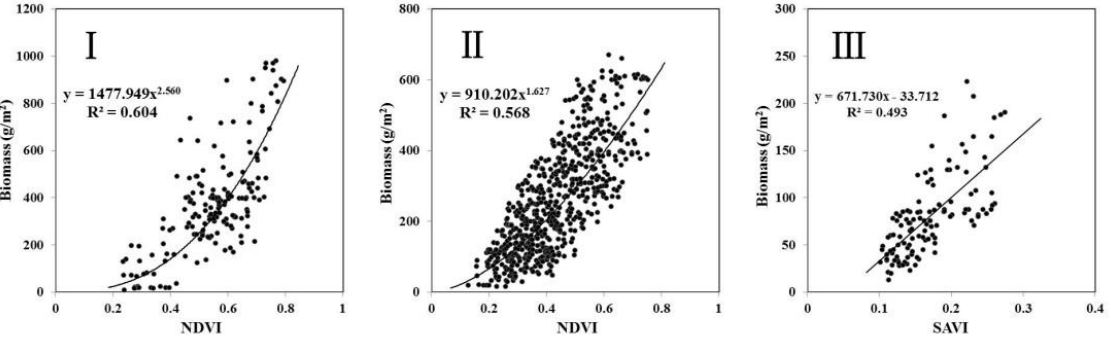
Figure 2. Relationship between VI and biomass: Region I, Region II and Region III. Region I and Region II selected the power function model based on NDVI; Region III selected the linear function model based on SAVI.